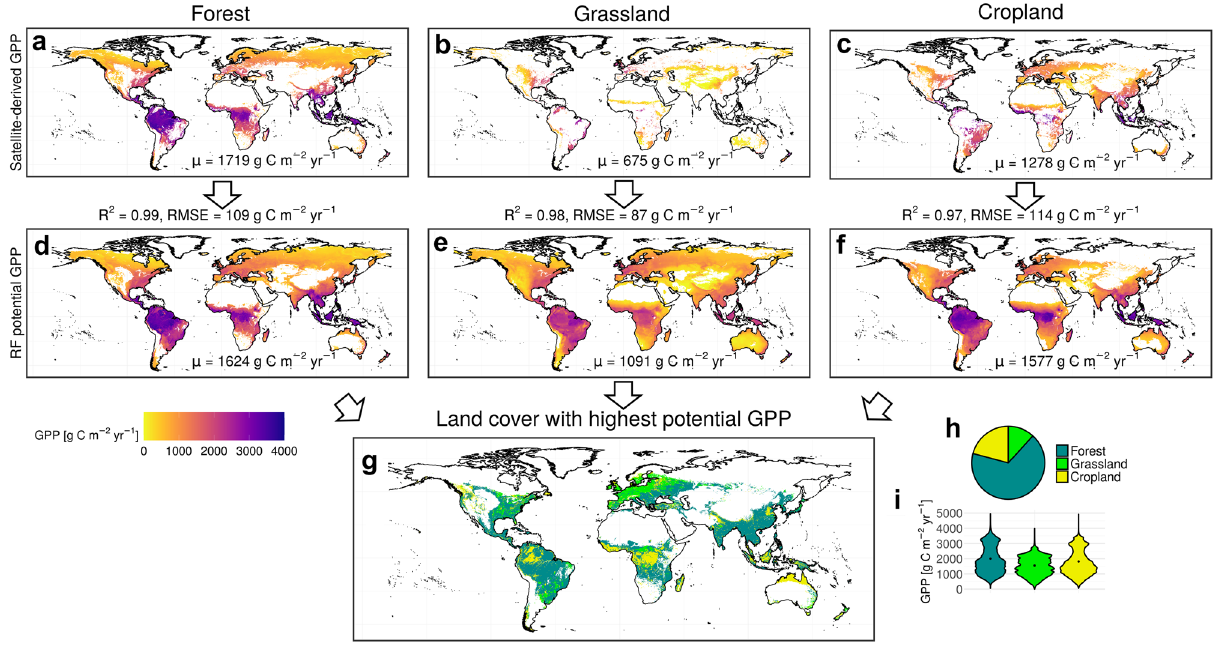
Figure 1. Maps of potential GPP for different land cover types derived from RF predictions. ( a – c ) Satellite- derived present-day GPP for forests ( a ), grasslands ( b ) and croplands ( c ) (i.e., the training data). ( d – f ) Potential GPP predicted by the RF algorithm. ( g ) Land cover with highest potential GPP according to ( d – f ). ( h ) Global fractions of the most productive land cover type. i , Potential GPP distribution across the total suitable area. R 2 and RMSE values are computed on the out-of-bag testing data. The good model performance can partly be explained by the very large training data and to some degree by spatial autocorrelation 24 (Supplementary Discussion 2 and Figs. S3 and S4). Global area-weighted GPP means are given by the numbers at the bottom of the maps. Grid cells where no forests exist today or potential forest cover (Supplementary Fig. S5) is < 36.3% (i.e., means. Maps were created using R version 4.1.0 (https:// cran.r- proje ct. org/) 25